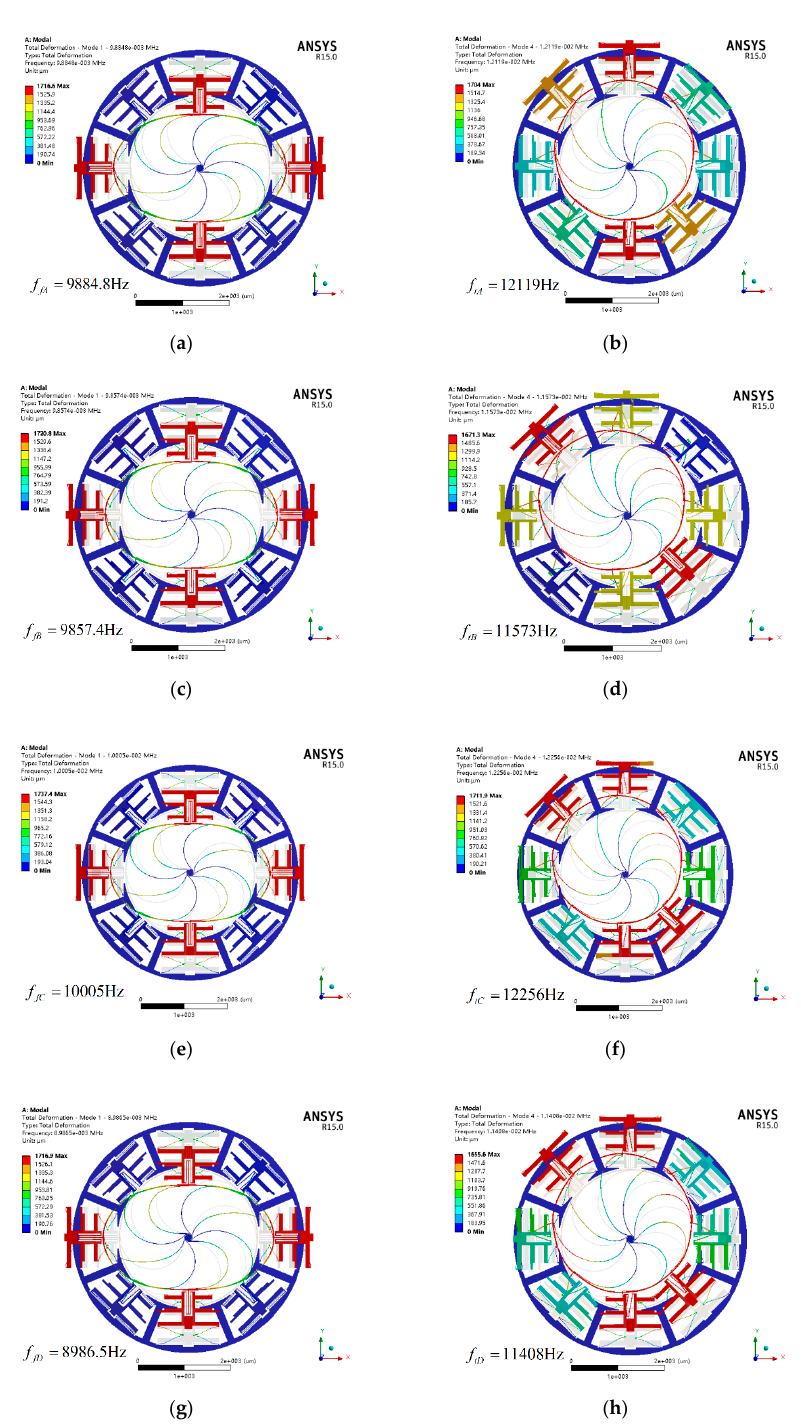
Figure 8. Flexural modal diagram ( a ), ( c ), ( e ), ( g ) and translation modal diagram ( b ), ( d ), ( f ), ( h ) of type A, B, C, and